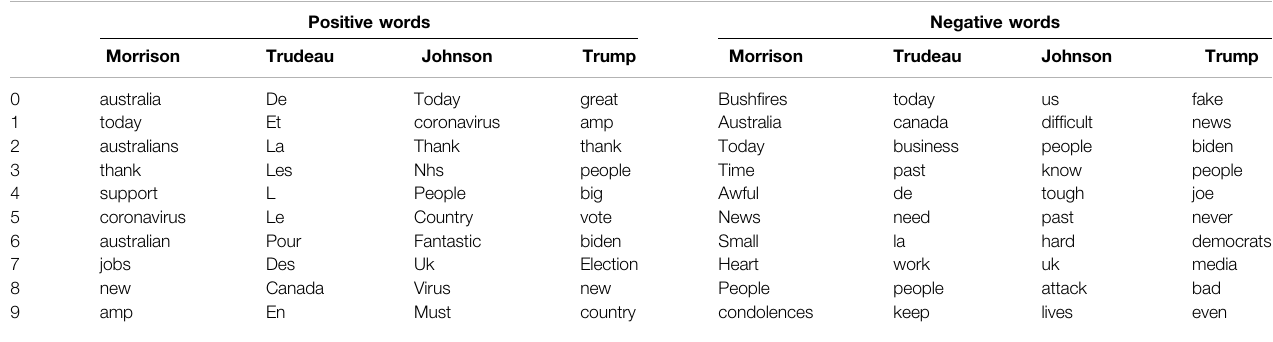
TABLE 3 | Top 10 most common positive and negative words from each politician. Positive words